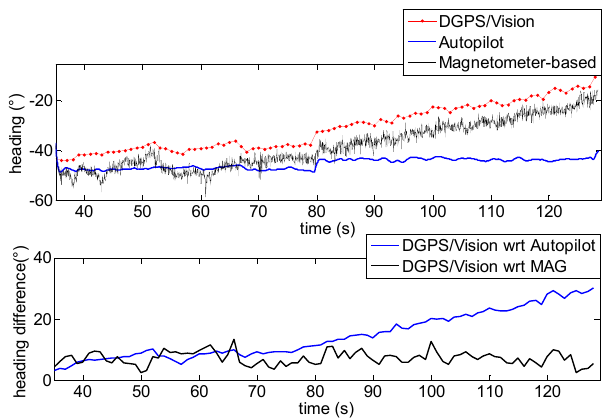
Figure 20. Heading angle as a function of time ( Top ), differences of DGPS/Vision with respect to autopilot and magnetometers ( Bottom ) during the first flight segment (Test 2). Sensors 2016 , 16 , 2164